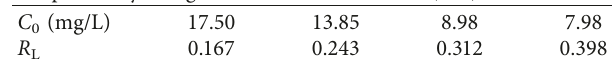
Figure 10: Mean scores of four tested sensory attributes (odor, color, taste, and overall acceptance) of C. papaya leaf extracts. a–d: different alphabets indicate a significant difference ( p 0 . 05). < Table 5: Kinetic study on adsorption activity of the saponin compound by using resin Diaon WA30 10%